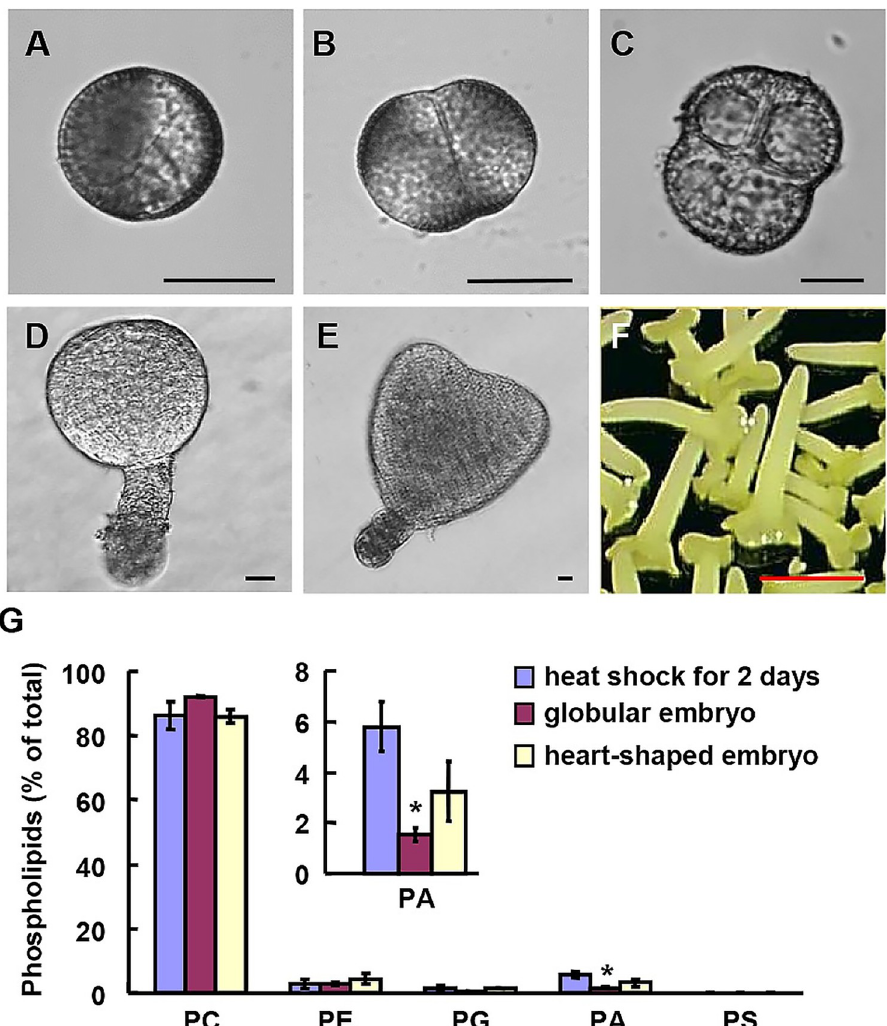
Fig 1. Dynamics of phospholipids at different stages during microspore embryogenesis of Brassica napus . (A-F) Microspore embryogenesis of Brassica napus , including vacuolated microspore (A), two-cells proembryo cultured for 48 h (B), four-cells proembryo cultured for 3 d (C), globular embryo with a suspensor cultured for 6 d (D), heart- shaped embryo with a suspensor cultured for 10 d (E), and cotyledonary embryos cultured for 28 d (F) after heat-shock treatment. Bars = 25 μ m (A-E), or 1.5 mm (F). (G) Embryos at developmental stages A, D and E were collected and amounts of various phospholipids were measured by a lipidomics approach, which were shown as the percentage of total phospholipids. PC, phosphatidylcholine; PE, phosphatidylethanolamine; PG, phosphatidylglycerol; PA, phosphatidic acid; PS, phosphatidylserine. Experiments were performed with three technical replicates and data were mean ± SE. Statistical significance was determined by student’s t test ( � , P < 0.05).